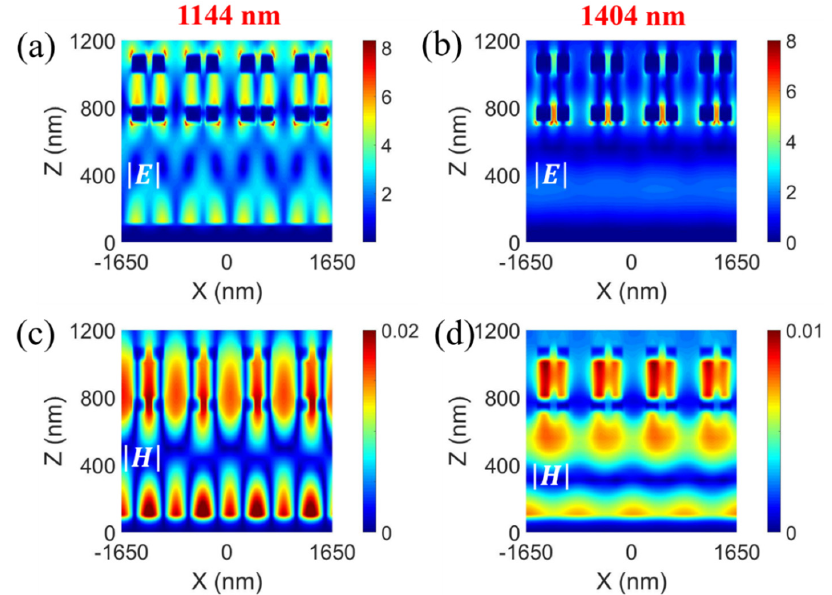
Figure 4. Electric field |𝑬| and magnetic field |𝑯| distributions at ( a,c ) 1144 and ( b,d ) 1404 nm. Sensors 2020 , 20 , x FOR PEER REVIEW